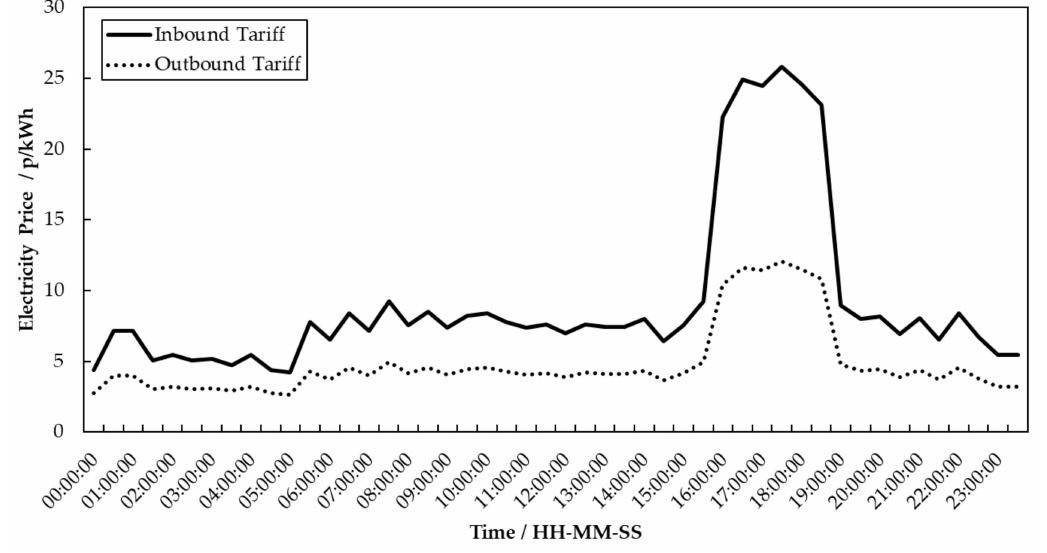
Figure 4. Plot showing the price variation in the Octopus Energy Agile Tari ff —06 / 01 / 20